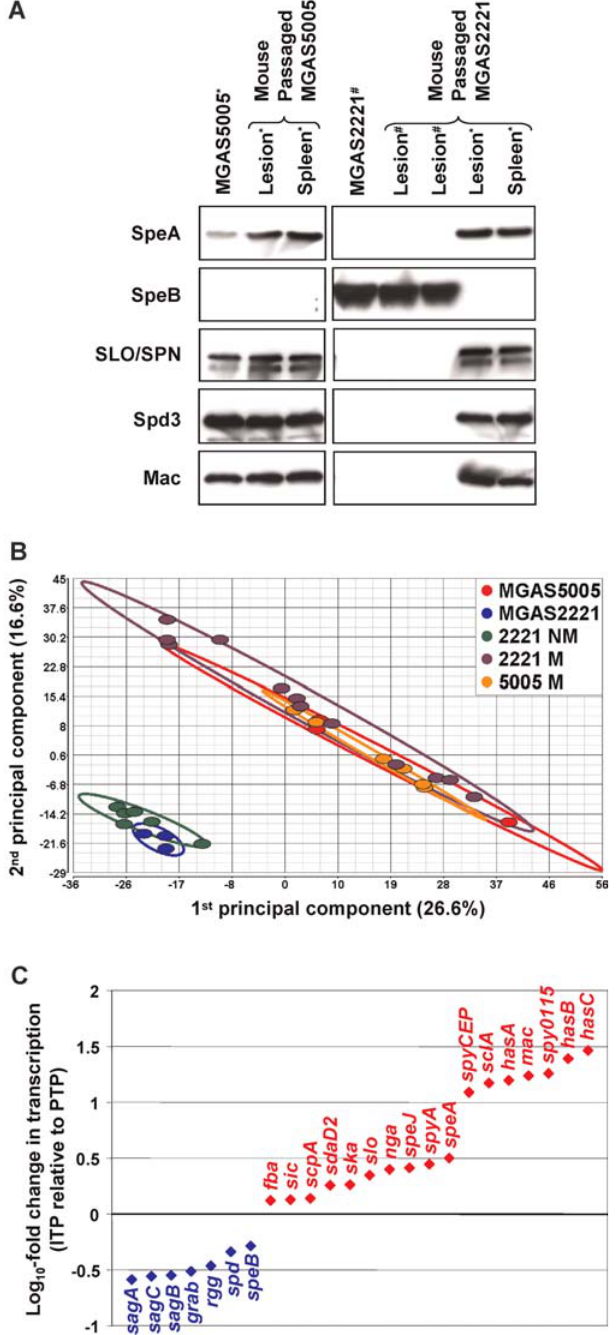
Figure 2. Mouse Passage Results in Recovery of ITP Derivatives from Infecting PTP GAS (A) Western immunoblots of supernatant proteins obtained from overnight cultures of ITP and PTP GAS isolates, before and after mouse passage. The amount of immunoreactive SpeA, SpeB, SLO/SPN, Spd3, and Mac was unaffected by mouse passage of the ITP strain MGAS5005, whereas they were affected by all spleen and some lesion-isolated GAS after mouse passage of the PTP GAS isolate MGAS2221. Strains with a mucoid colony morphology are indicated with an asterisk (*), while nonmucoid strains are indicated by a hash (#). (B) Principal component analysis plot portraying PTP to ITP transition for several mouse-passaged derivatives of strain MGAS2221. The 2221 NM (green) and 2221 M (purple) data points are mouse-passaged derivatives of strain MGAS2221 with distinct nonmucoid and mucoid colony morphologies, respectively. The 5005 M (orange) data points